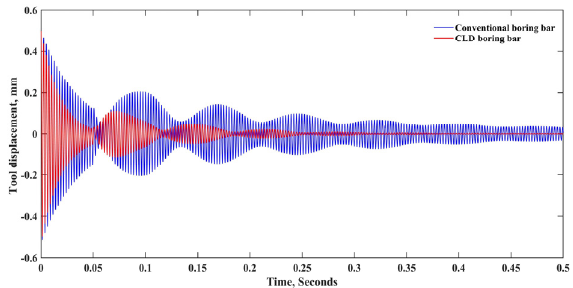
Figure 10. Tool-tip displacements of the conventional and CLD boring bar at a speed of 1200 rpm and 0.05 mm depth of cut